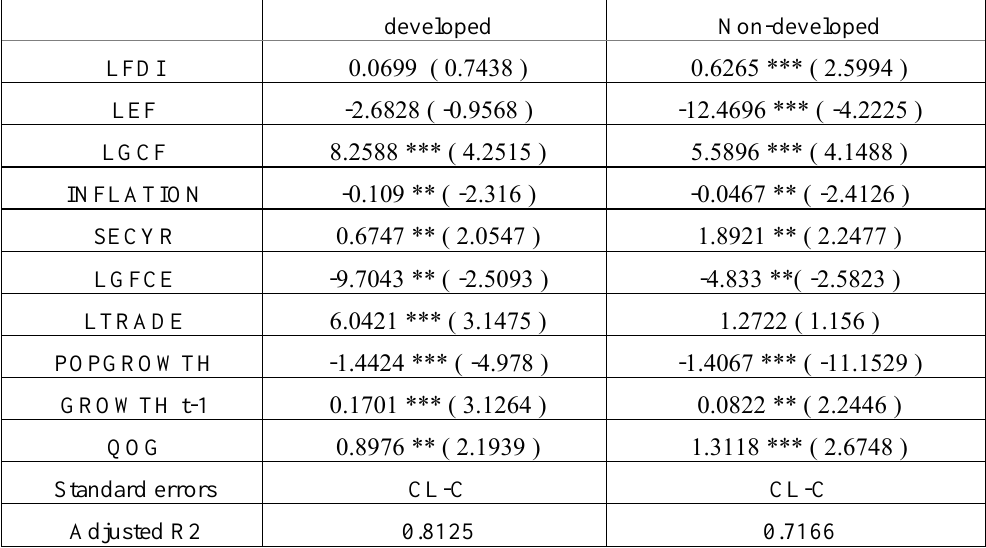
Table 6. relation between per capita GDP growth and (log) net foreign direct investment inflow in developed countries and other economies(Relation(2)) developed Non-developed LFDI 0.0699 ( 0.7438